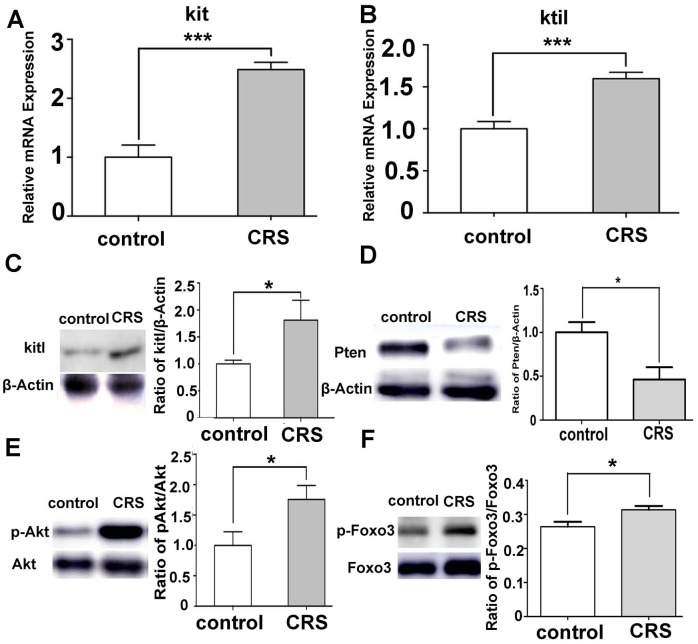
CRS increased the expression of Kitl/Kit and triggered the activation of PTEN/PI3K/Akt pathway.(A, B) The mRNA expression level of Kit and Kitl in mouse ovaries of both CRS and control groups (n = 6, P< 0.001). (C) The protein expression level of Kitl in the ovaries of the CRS group was significantly higher compared with that in the control group (n = 6, P< 0.05, normalized according to the b-Actin values). (D) The expression level of PTEN decreased significantly in the ovaries of the CRS 8w group (n = 6, P< 0.05). (E) The ratio of pAkt protein expression level to Akt values in the ovaries of the CRS group was significantly higher compared with that in the control group (n = 6, P< 0.05). (F) The ratio of pFoxo3 protein expression level to Foxo3 values in the ovaries of the CRS group was significantly higher compared with that in the control group (n = 6, P< 0.05). CRS, Chronic restraint stress.